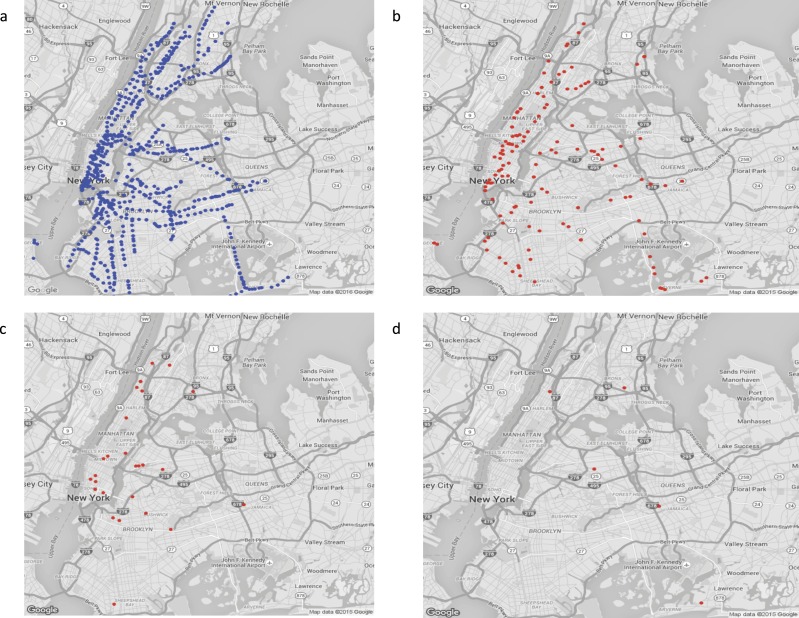
Distribution of S. aureus subtypes identified from the New York City subway metagenome data.(A) A map of all sites sampled by Afshinnekoo et al. (2015) (31) in the central Manhattan area, (B) sites containing any S. aureus reads (C) sites containing CC30 (beta > 0.2; v2 classification), (D) sites containing CC22. Maps © Google.